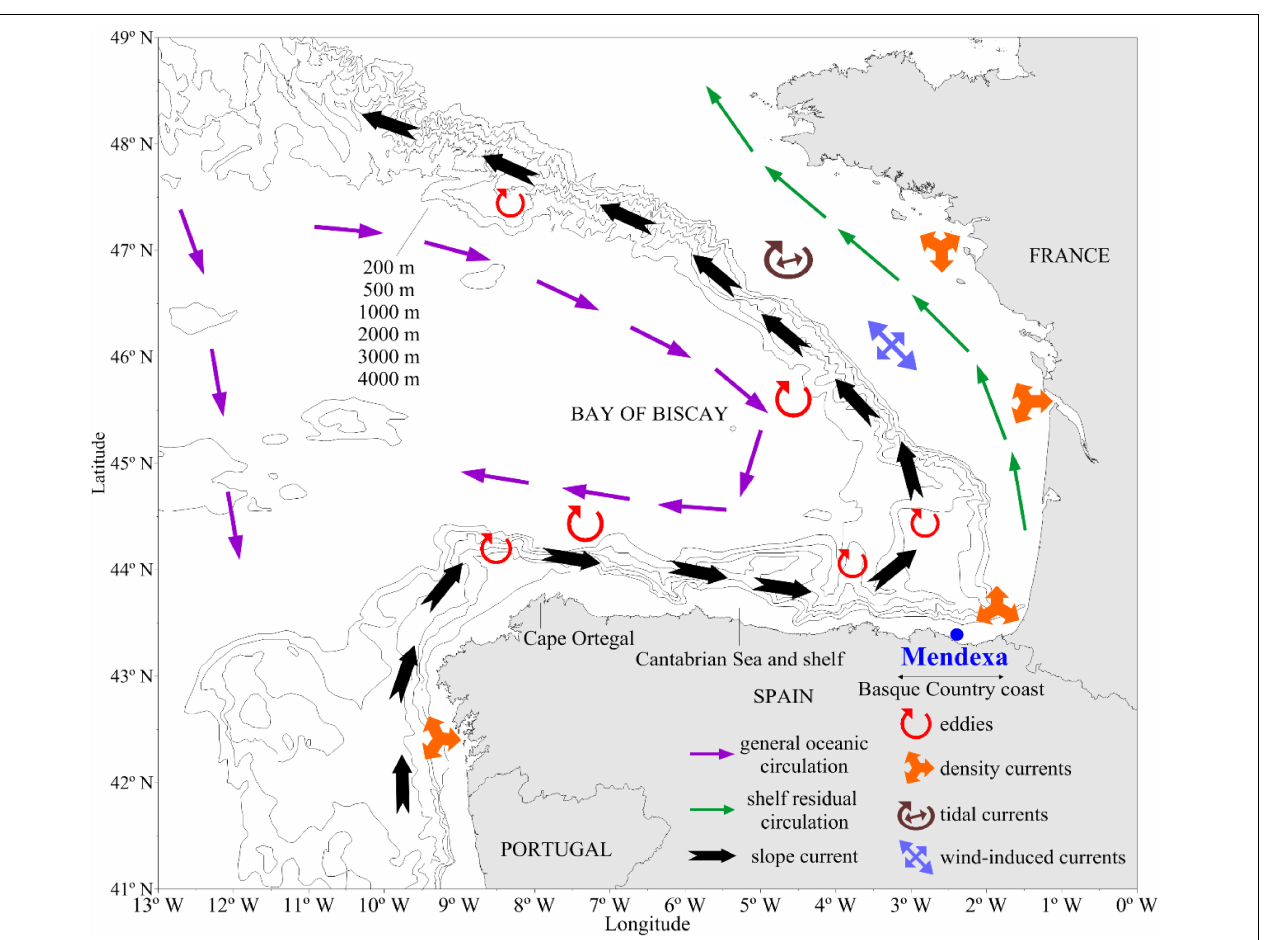
FIGURE 3 | Map of main physical characteristics in the Bay of Biscay [adapted from Ferrer and Caballero